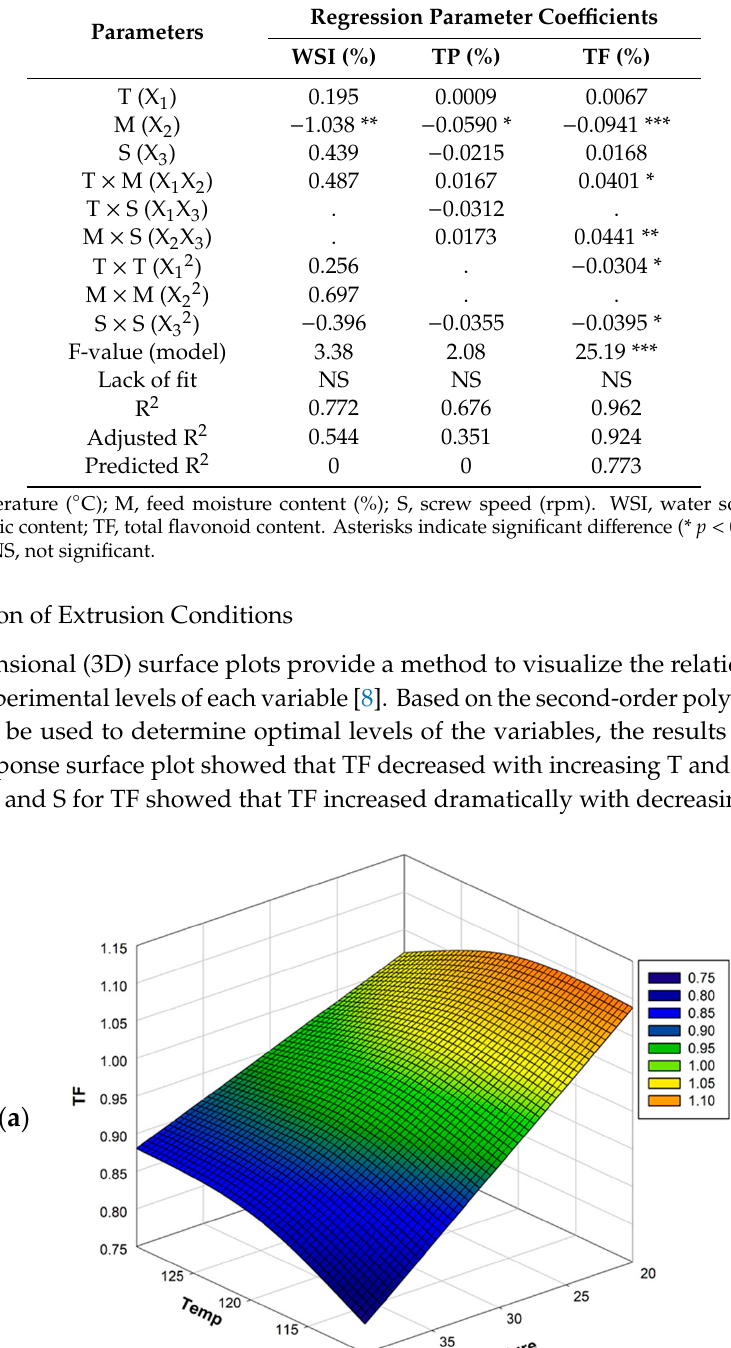
Table 2. Regression summaries for independent variables.